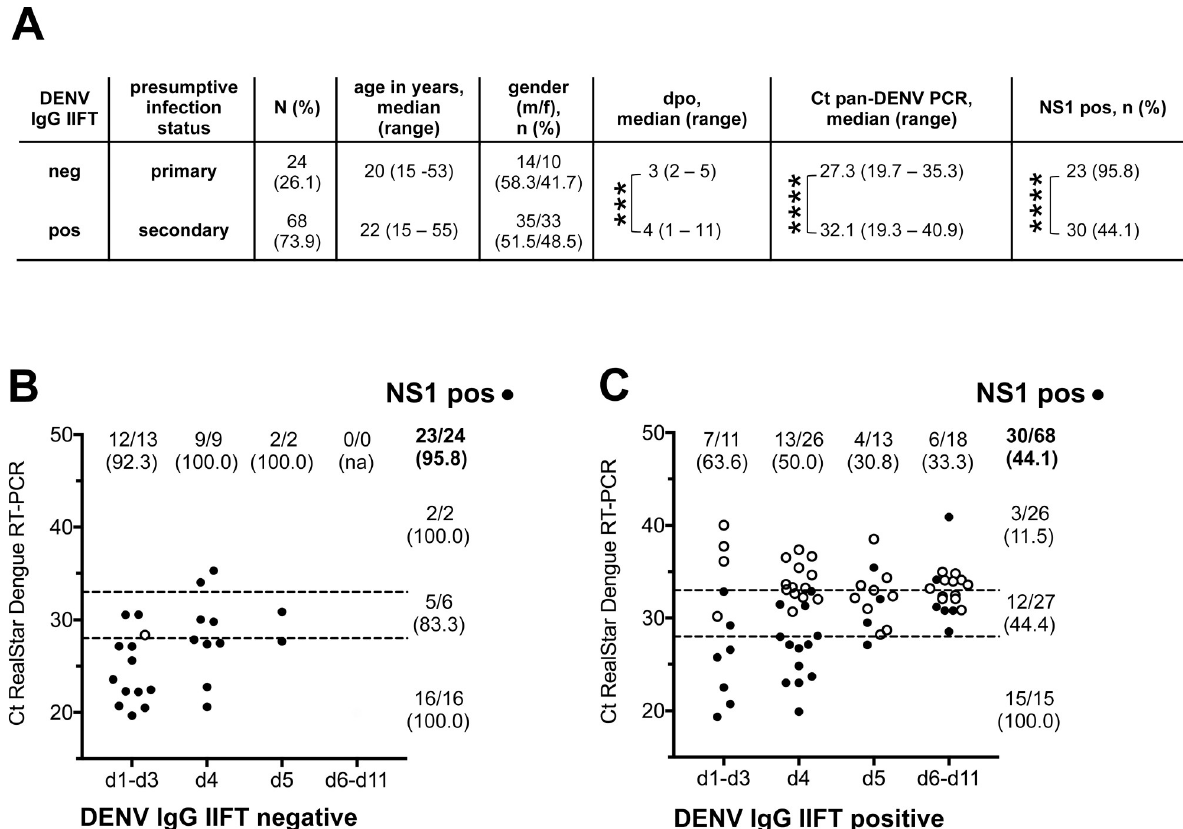
Fig 2. SD Bioline Dengue Duo NS1 test results stratified according to anti-DENV IgG status. Acute phase serum samples from 92 patients with a PCR-confirmed DENV infection were categorized according to their anti-DENV IgG status as defined by DENV IgG IIFT. (A) Tabular representation of subgroup characteristics. Ct: threshold cycle, dpo: days post onset of symptoms. (B) DENV IgG IIFT negative samples (N = 24), (C) DENV IgG IIFT positive samples (N = 68). Samples were stratified according to sampling day d (post onset of symptoms) and Ct-value (categories low ( � 28.0), medium (28.0 < Ct � 33.0), high (Ct > 33.0) indicated by dashed lines). Open/filled circles represent negative/positive NS1 test results. Absolut sample numbers (n positives / N samples in category) and percentages are displayed. ��� : p < 0.001, ���� : p < 0.0001.